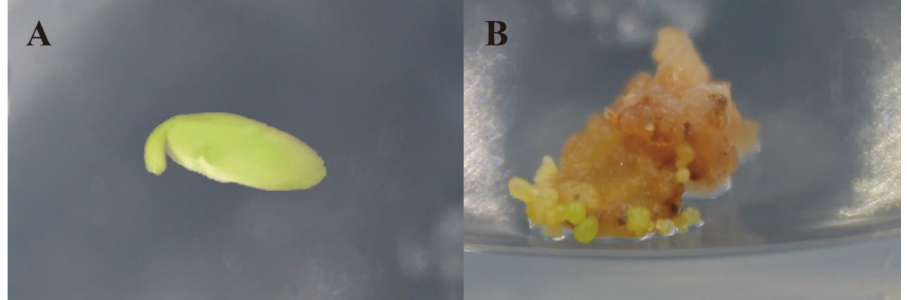
Figure 1. Somatic embryo culture process. ( A ) Immature embryo, before 2,4-D treatment; ( B ) Immature embryos treated with 2,4-D for 20 days.